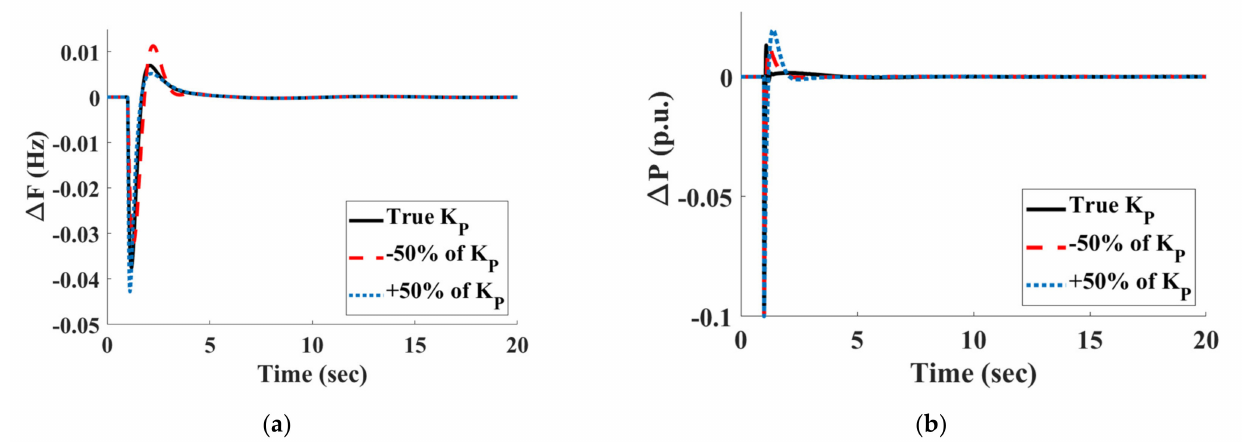
Figure 9. Sensitivity analysis of the HPSREG with the “PID-With-VI-FO-F-PID” configuration during ± 50% changes in K P : ( a ) ∆ F ( Hz ) and ( b ) ∆ P ( p . u . ) .